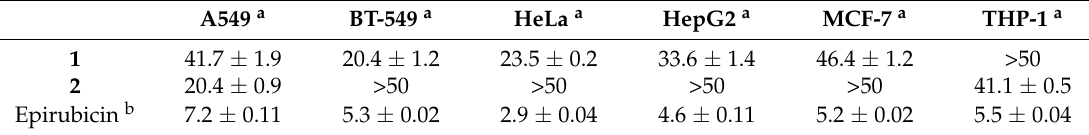
Table 2. Cytotoxicities (IC 50 , µ M) of compounds 1 and 2